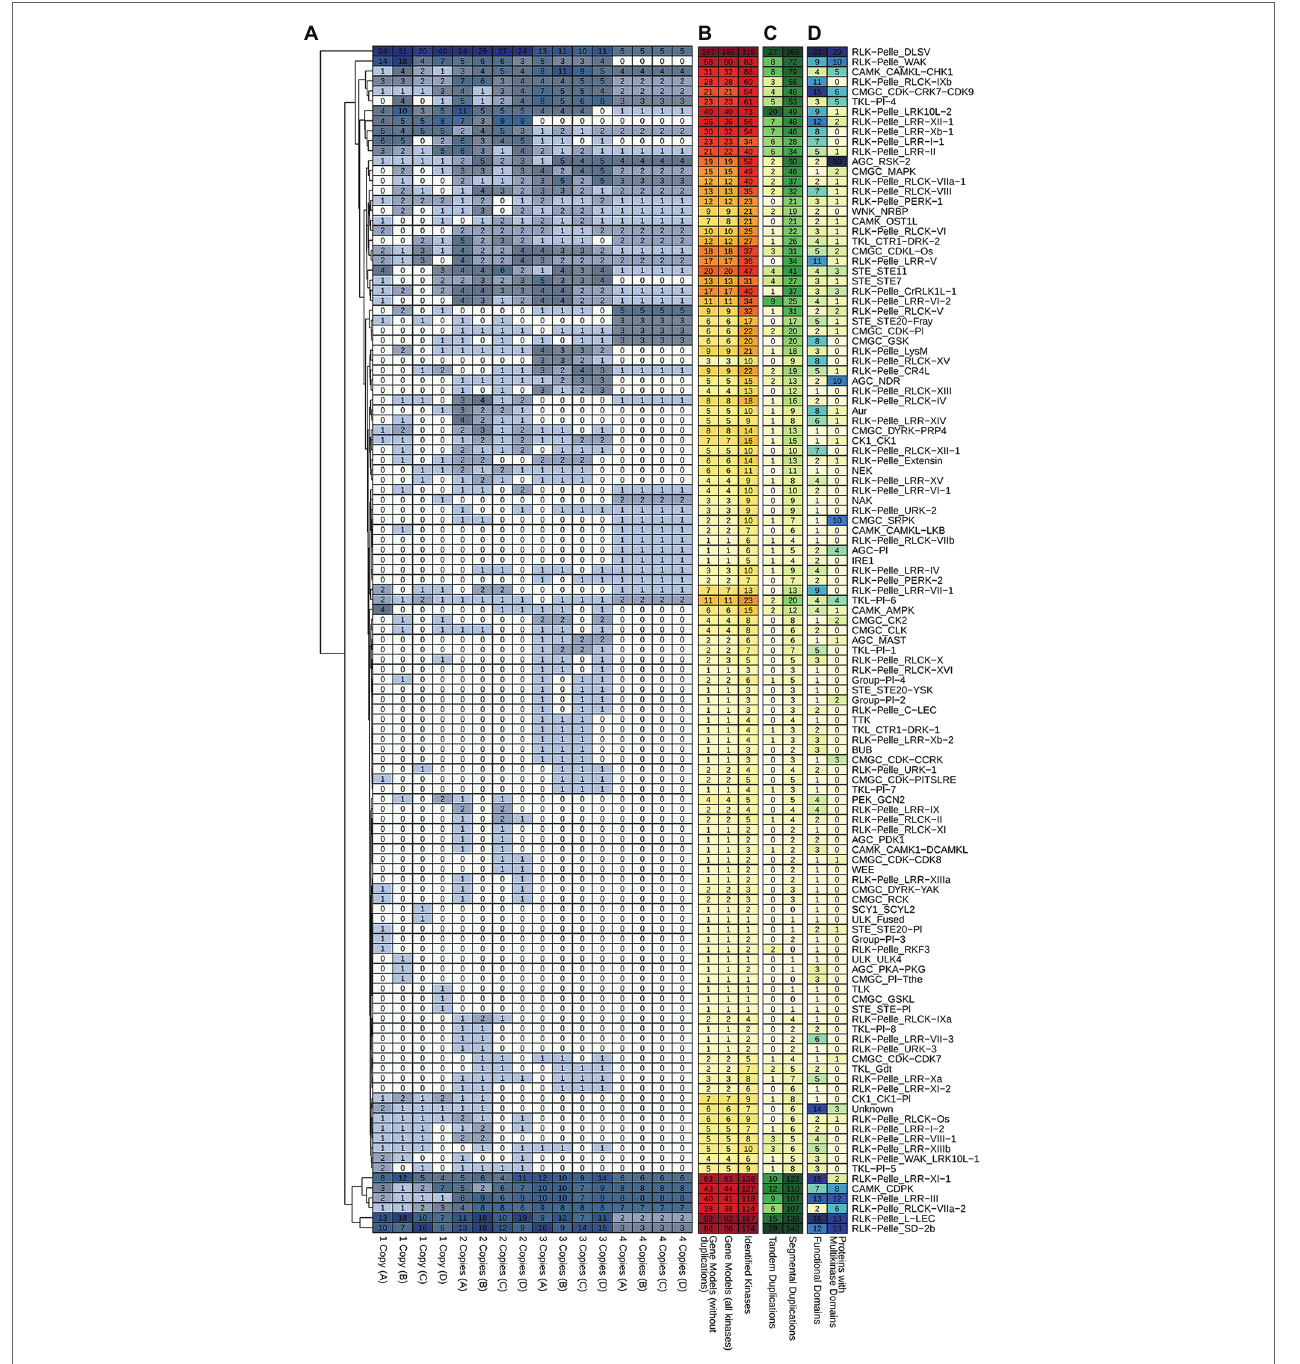
FIGURE 6 | Heatmap representations of kinase subfamily profiles in S. spontaneum related to (A) kinase copies among alleles. (B) Subfamily quantification considering the entire set of kinases and the respective quantity of gene models. (C) Tandem and segmental duplication events; and (D) the presence of different functional domains and multikinase domain-containing proteins within